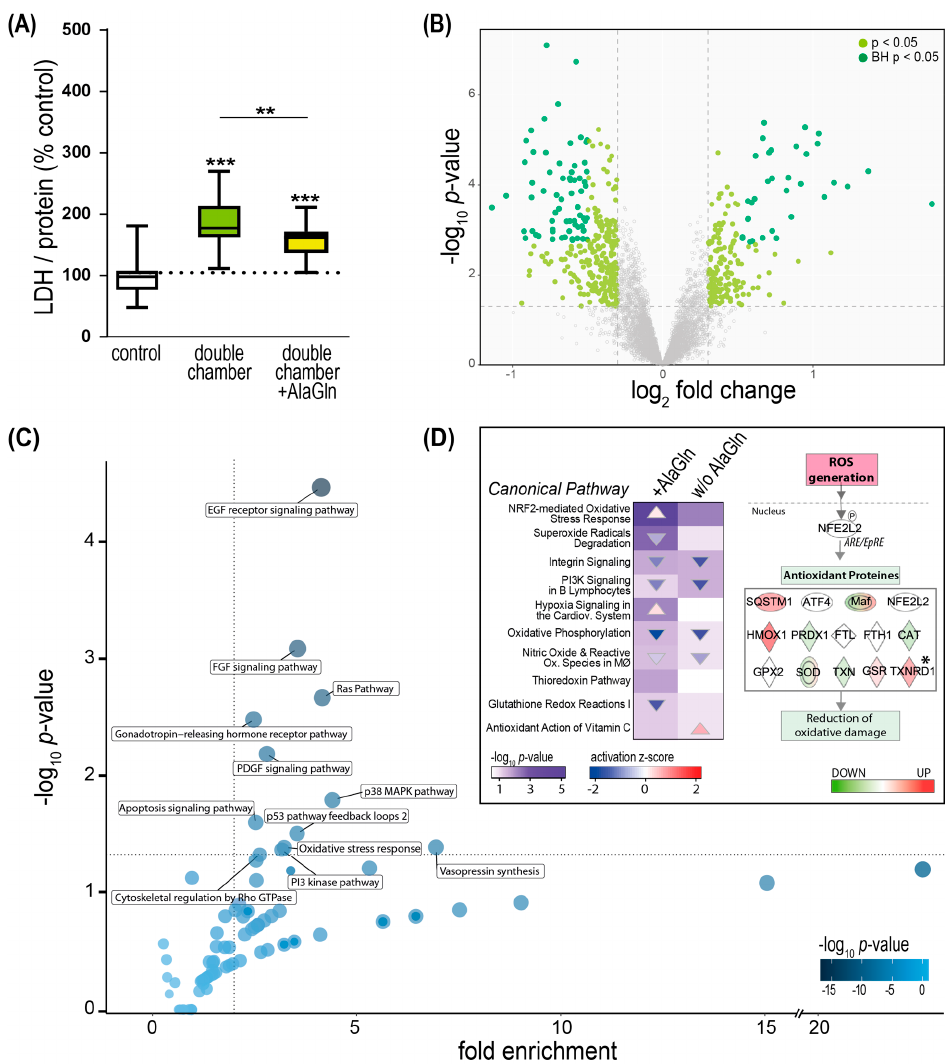
Figure 5. Effects of addition of alanyl-glutamine (AlaGln) to double-chamber PD fluids on endothelial cells. ( A ) Total protein-corrected lactate dehydrogenase (LDH) release into the cell supernatant ( n = 3 individual experiments from three different donors, each comprising in total 18 samples, means ± SEM). ** p < 0.01; *** p < 0.001 (ANOVA, post hoc: Tukey’s). ( B ) Volcano plots for regulated proteins in HUVEC exposed to double-chamber PD fluid with added 8 mM AlaGln vs. double-chamber PD fluid without the additive. Colored points are LIMMA p < 0.05 and log 2 [fold change] > 0.3. Dark green: adjusted p < 0.05 after Benjamini-Hochberg (BH) correction for multiple testing. ( C ) Panther pathways analysis for the proteins regulated by AlaGln in double-chamber PD fluid. Each bubble represents a pathway, the intensity of the blue color is proportional to the p -value. Significantly enriched pathways are labeled with their respective names (Fisher’s exact p < 0.05, fold enrichment > 2). ( D ) Heatmap of significantly (Fisher’s exact p < 0.05) regulated IPA canonical pathways following double-chamber fluid exposure compared with double-chamber PD fluid supplemented with 8 mM AlaGln. Only oxidative stress related pathways are shown. The p -value is visualized in violet by fill color intensity. Activation z-scores are indicated as up (activated; red) or down (deactivated; blue) colored arrows. The direction of the arrow reflects the direction of the regulation (predicted activation: up, predicted inhibition: down). The NRF2-mediated Oxidative Stress Response pathway was extracted from IPA, manually curated and modified, and overlaid with differentially regulated proteins following exposure to double-chamber PD fluid with AlaGln vs. double-chamber PD fluid alone. Down-regulated proteins (green) and up-regulated proteins (red) * p = 0.042